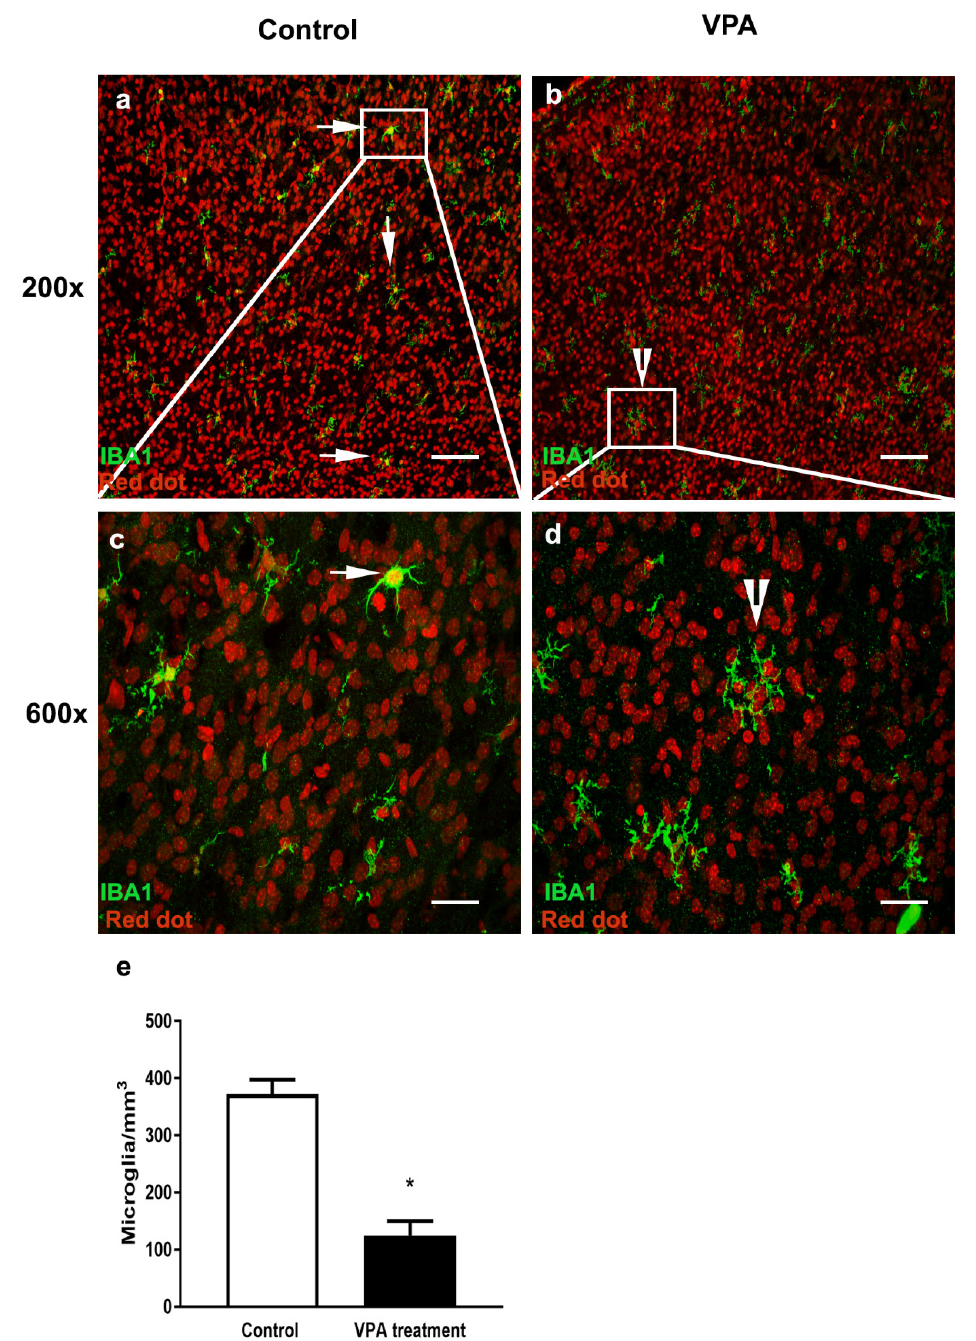
Figure 1. VPA-treated male mice show decreases in microglial number and fragmented morphology in primary motor cortex at P6. Confocal images showing labeled microglia in the PMC of saline control and age-matched brains of VPA mouse model of autism. ( a , b ) Microglia labeled with Iba1 (green) in control and VPA-treated mice at low magnification (200 × ). ( c , d ) Microglia labeled with Iba1 (green) at high magnification (600 × ). White square region (insert) in a and b is magnified in c and d. White arrows and arrowheads indicate differences in morphology of microglia in control and VPA model. Scale bar ( a , b ) 200 µ m and in ( c , d ) 50 µ m. ( e ) Analysis of number of microglia as summarized within the bar graphs (Mean ± SEM) reveals a statistically significant decrease in microglial number in VPA-treated mice (* p = 3.7 × 10 − 5